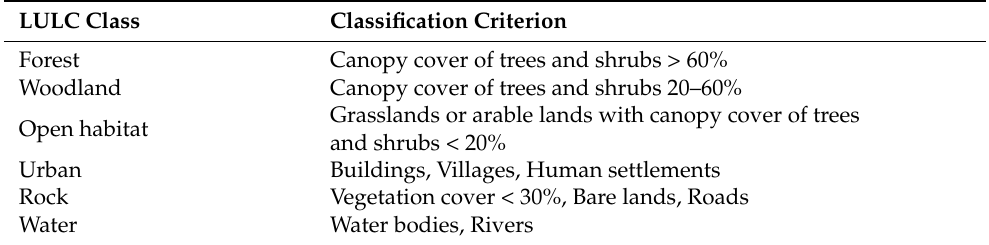
Table 1. List of Land Use/Land Cover (LULC) classes identified within the study area and the criteria employed for their classification. LULC Class Classification Criterion Forest Canopy cover of trees and shrubs >